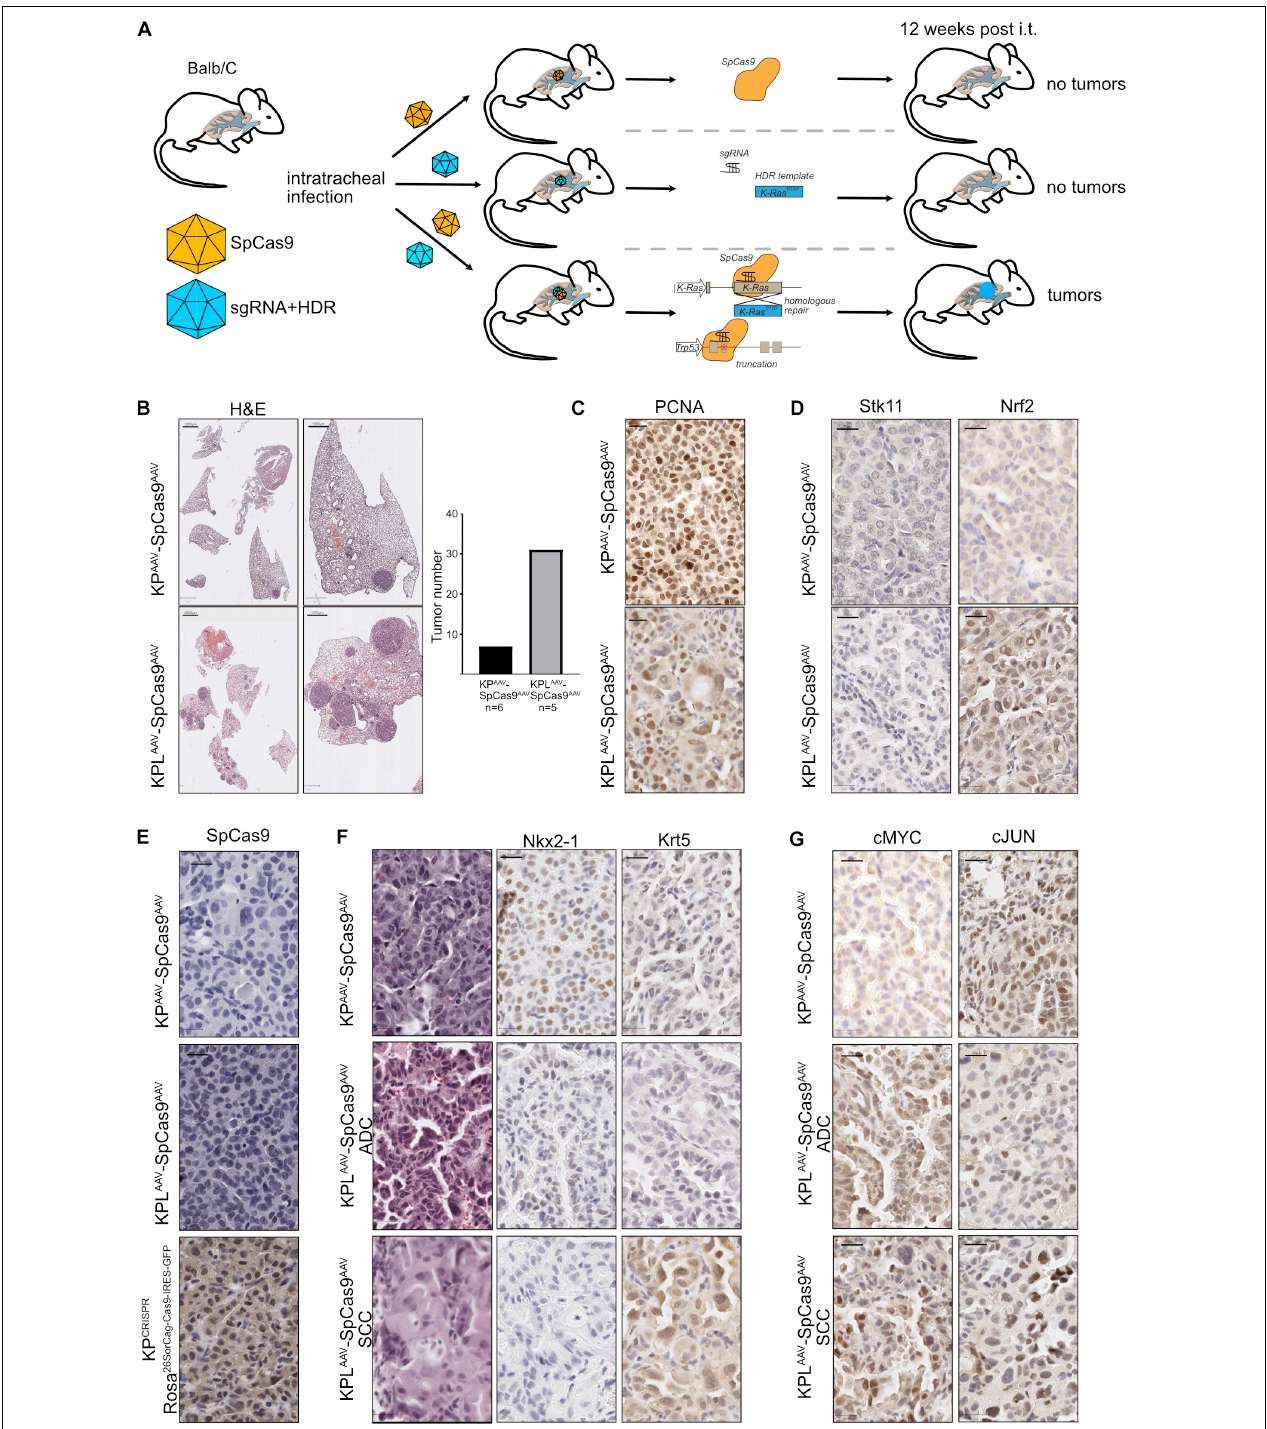
FIGURE 5 | Dual viral approaches enhance the applicability of CRISPR for translational research, irrespective of the mouse strain. (A) Schematic diagram of the dual AAV approach of intratracheal infection of mice to induce spCAS9-mediated lung tumor formation. (B) Representative H&E images of tumor-bearing animals 12 weeks post intratracheal infection (scale bars 2,000 and 1,000 µ m). Quantification of absolute tumor numbers in all KP or KPL animals co-infected with an AAV-spCas9. N = 6. (C) Representative IHC images of PCNA in KP AAV SpCas9 AAV and KPL AAV SpCas9 AAV (scale bar 20 µ m). (D) Representative IHC images of Lkb1/Stk11 and Nrf2 in KP AAV SpCas9 AAV and KPL AAV SpCas9 AAV (scale bar 20 µ m). (E) Representative IHC images of spCas9 in KP AAV SpCas9 AAV and KPL AAV SpCas9 AAV and KP CRISPR (Rosa 26 SorCag − Cas 9 − IRES − GFP ) (scale bar 20 µ m). (F) Representative IHC staining for Nkx2-1 and Krt5 in KP AAV SpCas9 AAV and KPL AAV SpCas9 AAV (scale bar 20 µ m). (G) Representative IHC staining for cMyc and cJun in KP AAV SpCas9 AAV and KPL AAV SpCas9 AAV (scale bar 20 µ m).